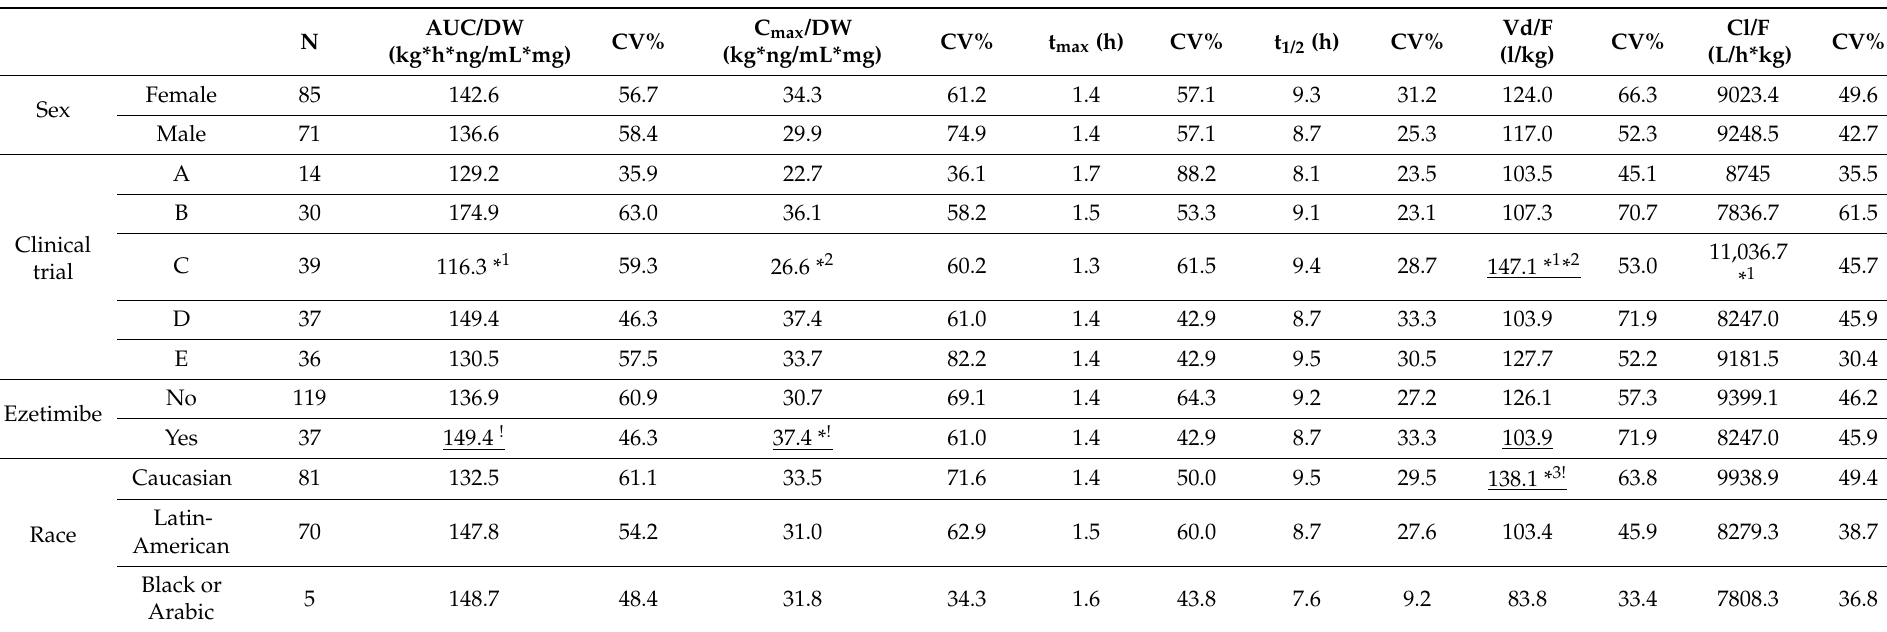
Table 3. Atorvastatin pharmacokinetic parameters based on sex, study design, use of ezetimibe, and